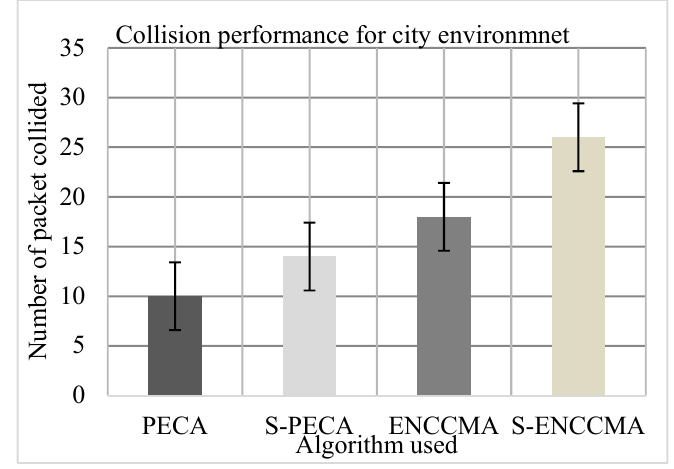
Figure 10. Collision performance for the city environment.